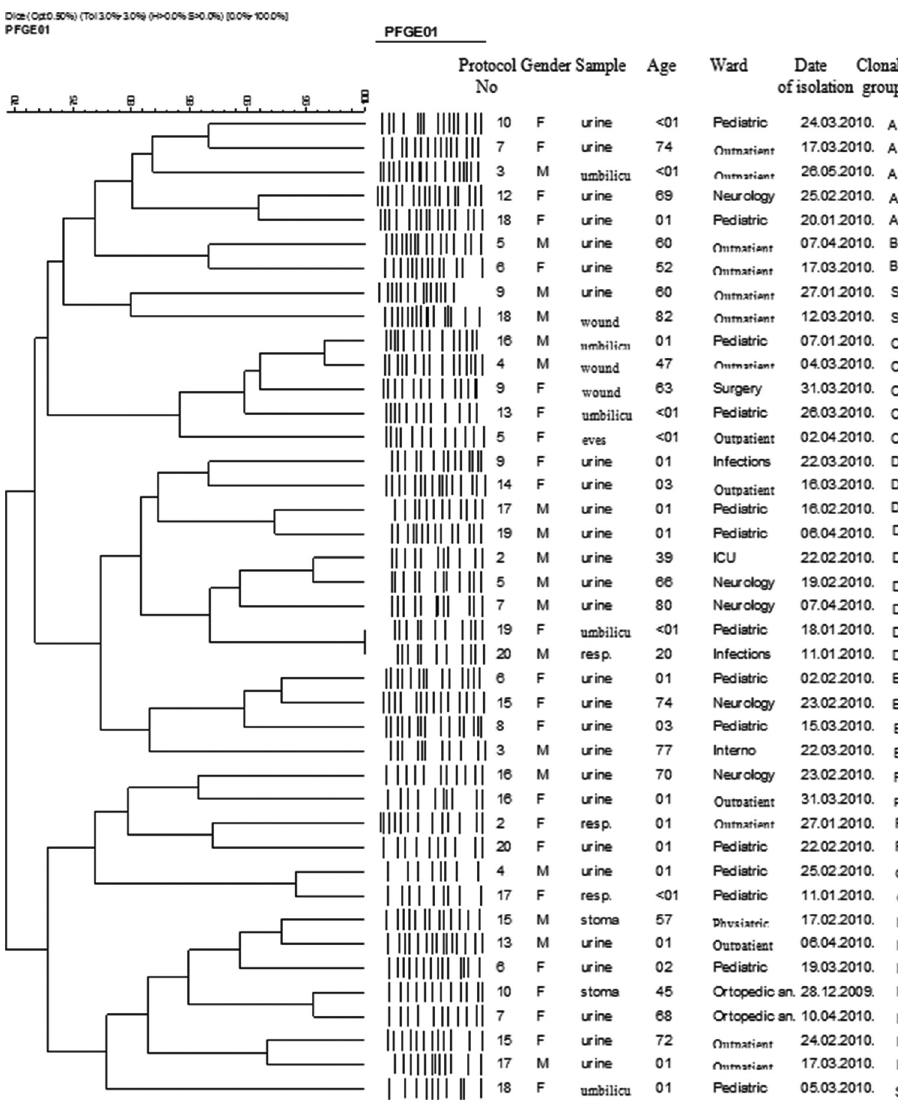
FIGURE 1. Dendograms showing the genetic relatedness of the 86 Enterobacteriaceae isolates . Eight (A-H) groups of Klebsiella pneu- moniae were identified by pulsed-field gel electrophoresis (PFGE) typing using the 80% similarity (a). Four clones consisted of more than five inpatient and outpatient isolates. PFGE typing was not successful in 21 isolates. Six (A-F) groups of Escherichia coli were identified by PFGE typing using the 80% similarity (b). Three clones consisted of three isolates in each of the two outpatients and one inpatient isolates. PFGE typing was not successful in 12 isolates. Four (A-D) groups of Proteus spp. were identified by PFGE typing using the 80% similarity (c). Only one consisted of three inpatient isolates. PFGE typing was not successful in one isolate. Two (A and B) groups of Enterobacter cloacae were identified by PFGE typing using the 80% similarity (d). One clone consisted of six isolates: Three inpatient and three outpatient isolates. Two (A and B) groups of Citrobacter freundii were identified by pulsed field gel electrophoresis typing using the 80% similarity (e). (a) K. pneumoniae , (b) E. coli , (c) Proteus spp., (d) E. cloacae , (e) C. freundii . ICU - Intensive care